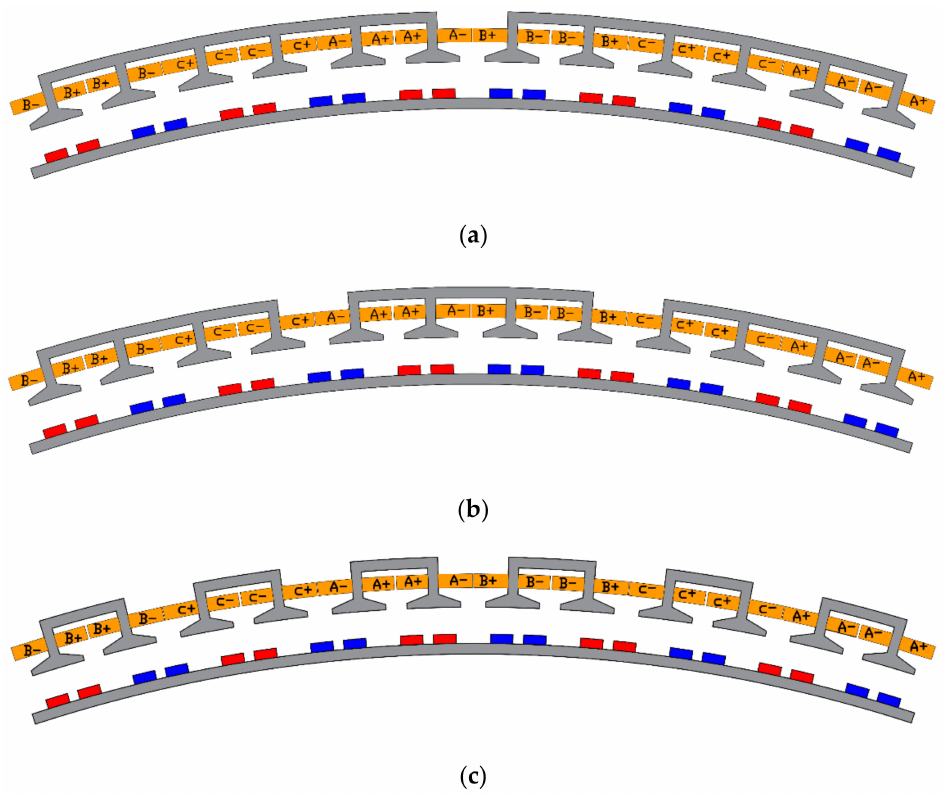
Figure 2. Modules of the APMM: ( a ) Two stator segments per module; ( b ) Three stator segments per module; ( c ) Six stator segments per module. Table 1. Main parameters and materials of the